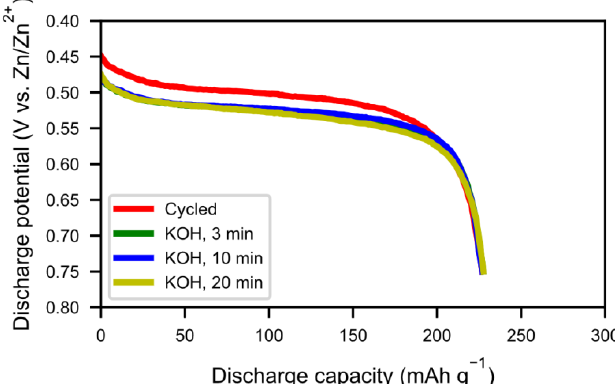
Figure 17. The discharge curves at 60 mA g − 1 for spent alkaline-treated cycled alloy at 3 min, 10 min, and 20 min, respectively.